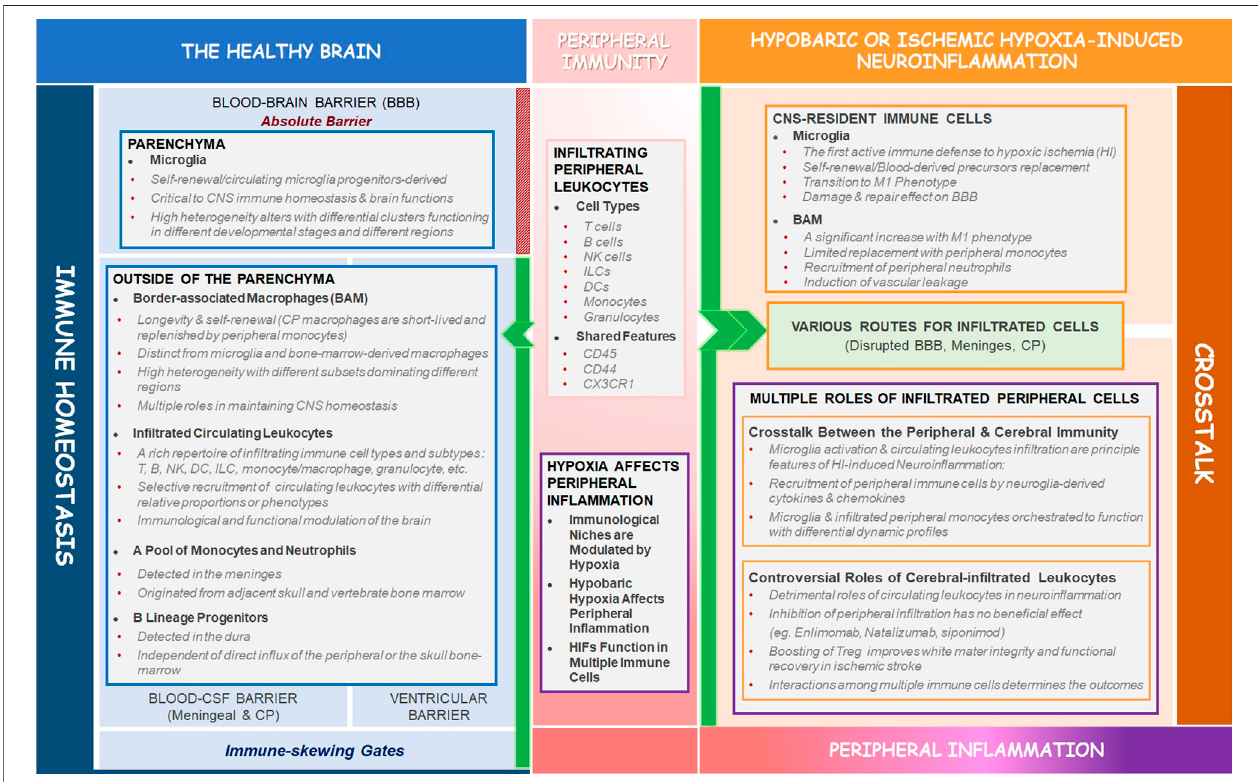
FIGURE 1| Schematic summary of the review. In the healthy brain, BBB acts as an absolute barrier to separate the parenchyma from circulating leukocytes, while outside of the parenchyma, the BCSFBs serve as active and selective immune-skewing gates to recruit circulating leukocytes with some shared markers (CD45, CD44, CX3CR1)totheinterfaces(meninges,CP,andperivascularspace)betweentheCNSandperipheralimmunity(theleftbluebox).Hypoxiacanplaycriticalrolesinaffecting peripheralin fl ammationunder both physiologicaland pathologicalconditions(the middle pinkbox). Inhypobaric-or ischemic hypoxia-induced neuroin fl ammation, the circulating leukocytes in fi ltrate into the parenchyma through disrupted BBB and alternative routes (meninges, CP). The CNS-residential immune cells (microglia and BAM) and in fi ltrated leukocytes interact with each other to determine the outcomes of brain injury. Controversial roles of the in fi ltrated peripheral immune cells in regulating hypoxia-induced neuroin fl ammation are of great importance (the right orange box) and are the hotspot of the future